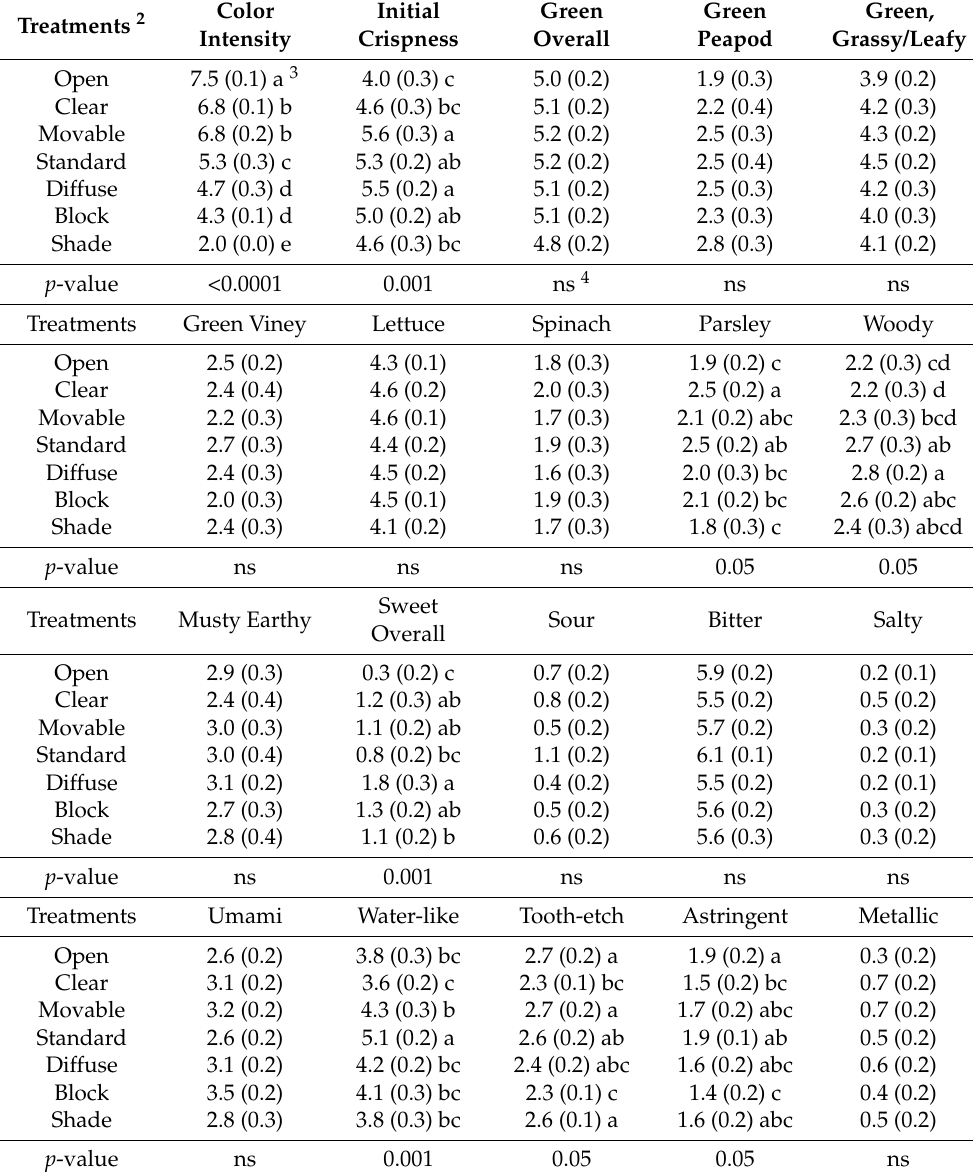
Table 3. Descriptive analysis attribute mean 1 scores and p -value of red leaf lettuce grown in high tunnel systems under six different high tunnel coverings or open